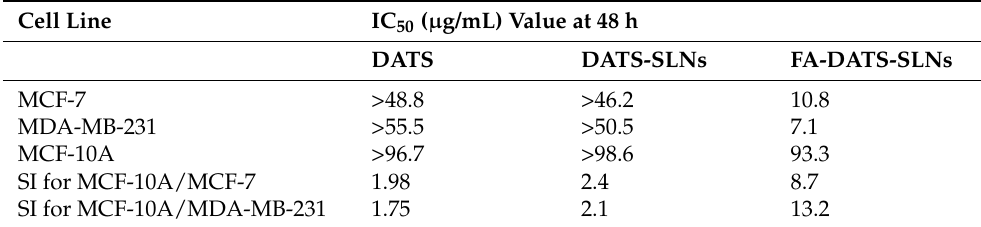
Figure 4. ( A ) Cytotoxicity studies in MCF-7, MCF-10A, and MDA-MB 231, and cell lines in vitro for 48 h. ( B ) MDA-MB-231 cell line colony formation assay. 1. Untreated cells (control); 2. cells treated with DATS; 3. cells treated with DATS-SLNs; 4. cells treated with FA-DATS-SLNs. The graphical representation indicates the % reduction of the colony formation compared with the control group ( p < 0.01) after the treatment. ( C ) MDA-MB-231 cell migration assay for the formulation of DATS, DATS-SLNs, and FA-DATS-SLNs. Table 1. IC50 value and Selectivity Index of DATS, DATS-SLNs, and FA-DATS-SLNs on MCF-7, MDA-MB-231, and MCF-10A cell